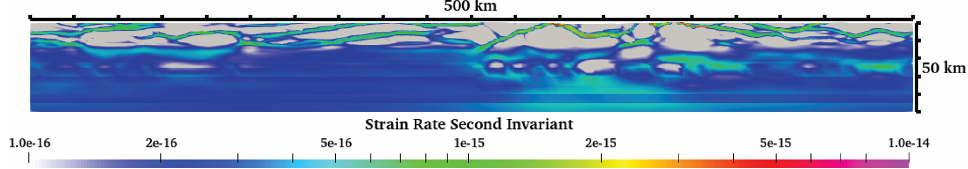
Figure B9. Cross section traversing all domains at x = 250km, perpendicular to those shown in Figs. B2–B7. Cross section shows the strain rate attribute. See Fig. 4c for a 10Myr snapshot. Screenshot taken at